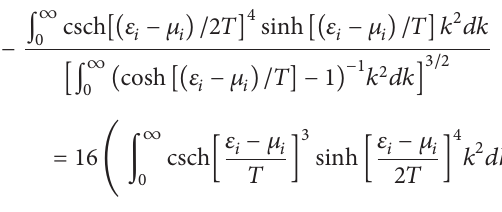
verify the critical behavior, but it can not be used as an origin to search for the chiral critical structure in QCD